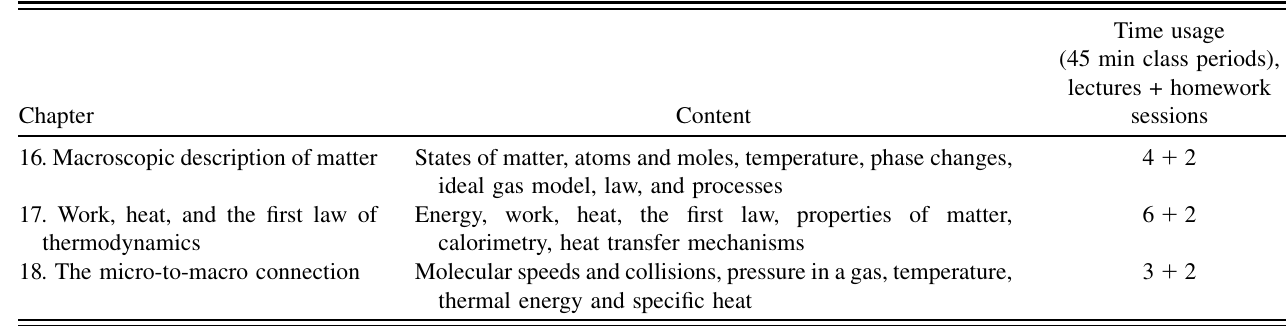
OVERCOMING STUDENTS’ MISCONCEPTIONS . . TABLE I. Time allocation in relation to the thermal physics content in the Basic Physics II course [22].